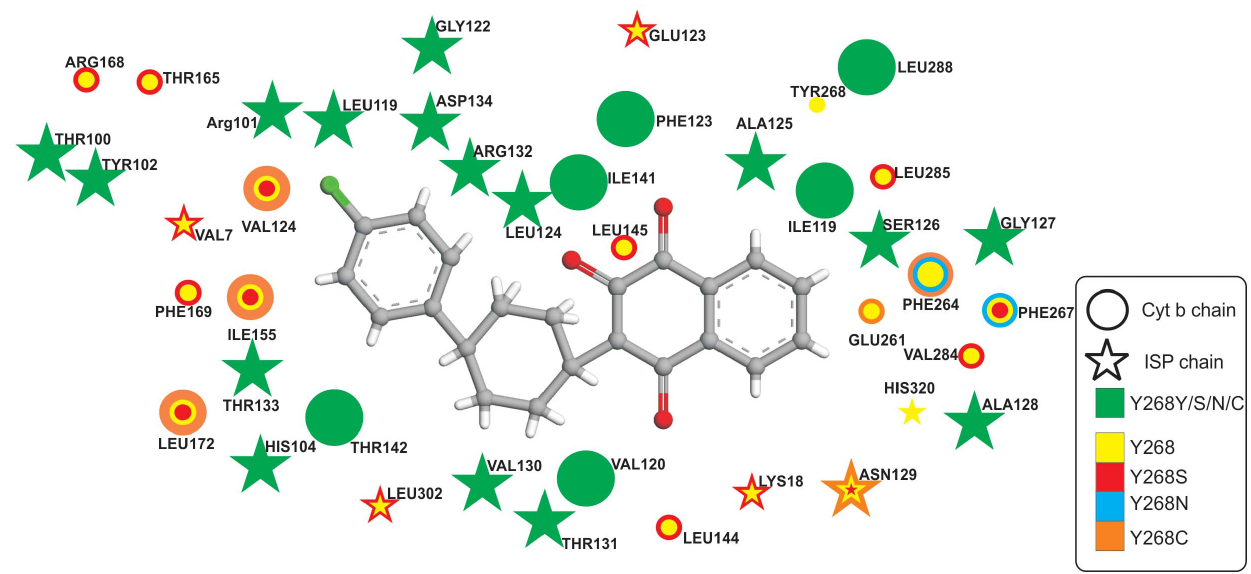
Figure 3. Two dimensional contact plots of amino acid residues from the wild and all screened mutant models of Cyt bc1 complex from P. falciparum in the vicinity of 5 A˚ radius around ATQ. It may be noted that in the mutant models the position 268 shifted away from the 5 A˚ radius of ATQ Binding site. Whereas green color indicates that the particular amino acid residue is present in the wild as well as in all mutant models in the observed area; yellow, red, blue, cyan color shows amino acid residues present only in wild type, Y268S, Y268N and Y268C mutant models respectively.